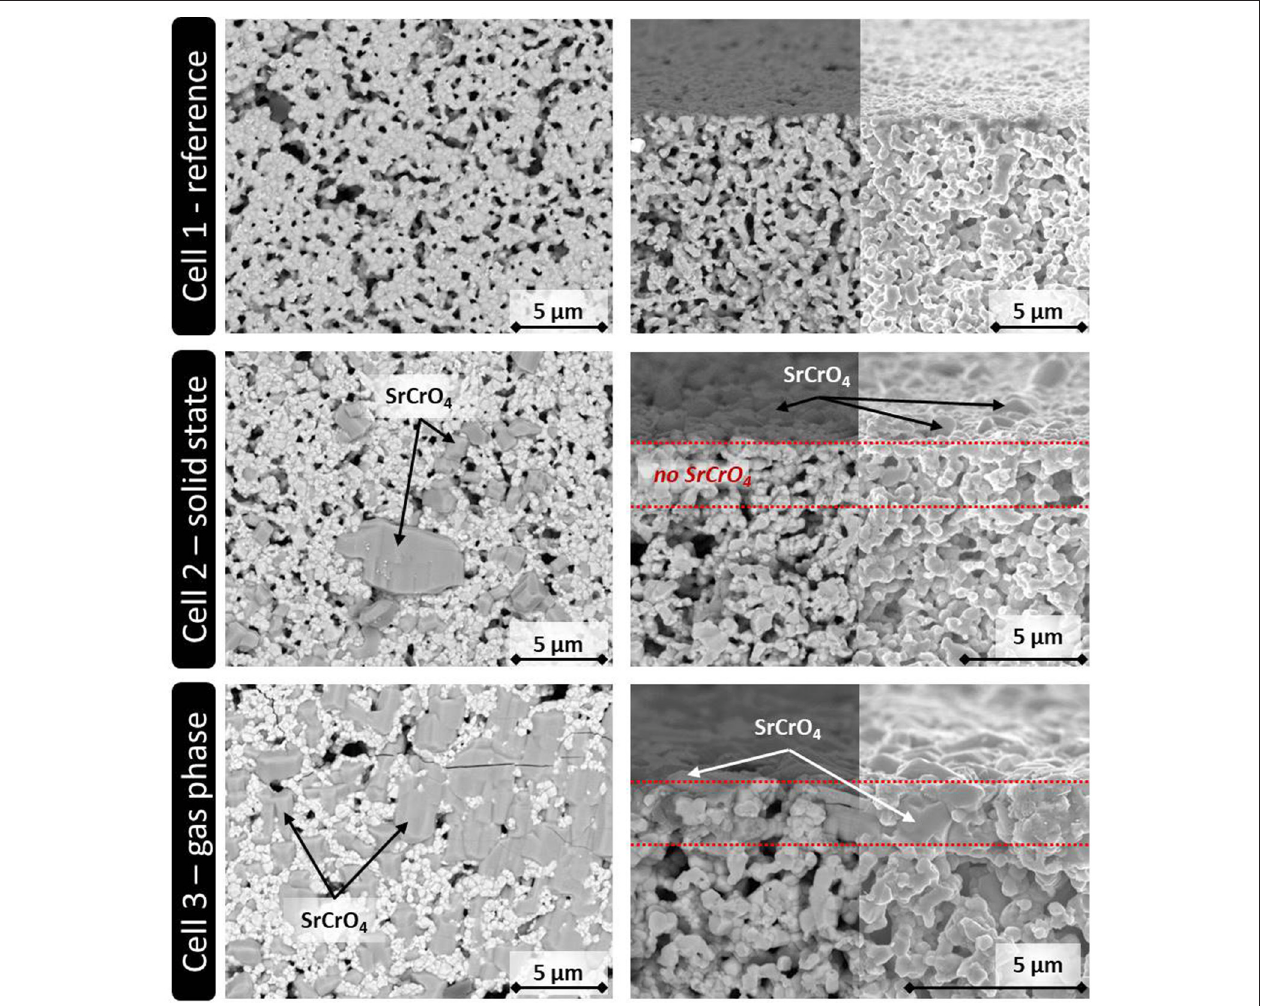
FIGURE 2 | SEM analysis of the three ASC button cells used for the electrochemical characterization. (Left) Top view. (Right) Fracture surface of the upper part of the cathode layer (backscattered electron detector/In-lens detector).